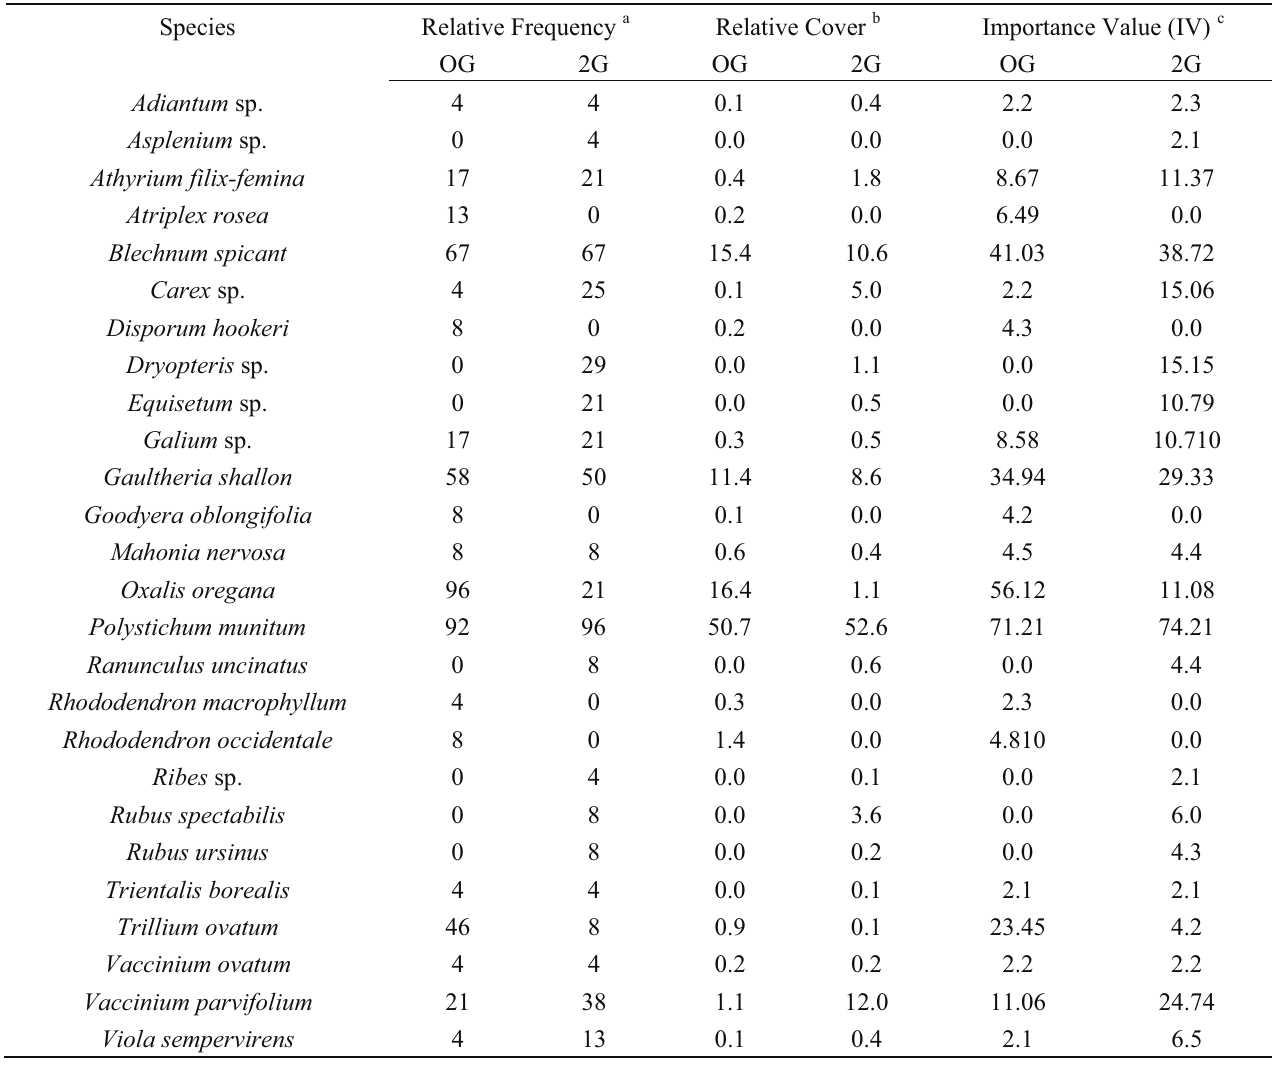
Table 2. Understory plant relative frequency, relative cover, and importance value (IV) in adjacent old-growth and second-growth riparian stands in Redwood National Park, USA. Species IV rankings are